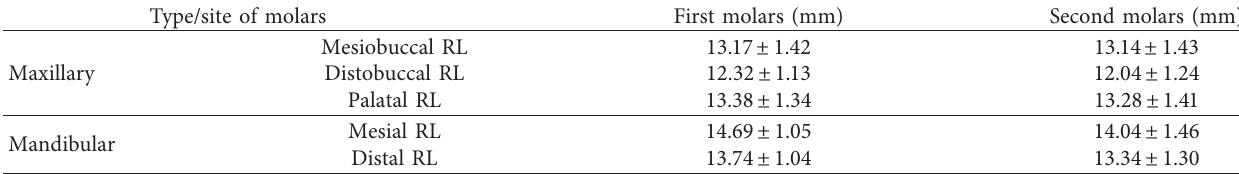
Figure 1: Different measured parameters in maxillary molar (a) and mandibular molar (b). RL: root length, RT: root trunk, and IRS: interradicular Table 1: Means ± SD (standard deviation) of root lengths of investigated teeth (mm).